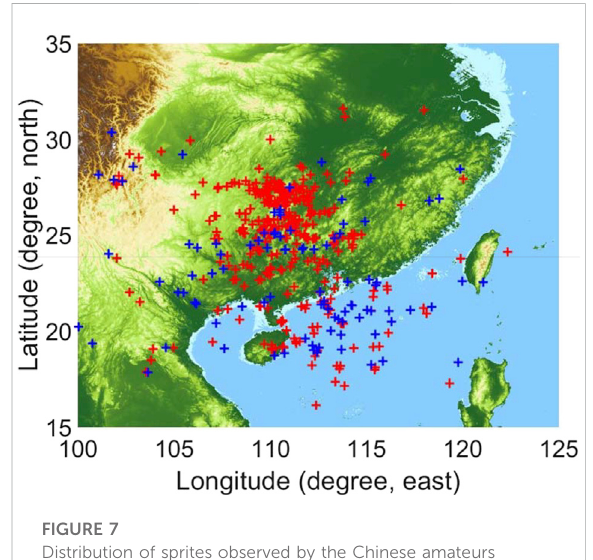
FIGURE 7 Distribution of sprites observed by the Chinese amateurs during2021.Redplusesandblueplusesrepresentthedetectionof positive and negative sprite-producing CG strokes,